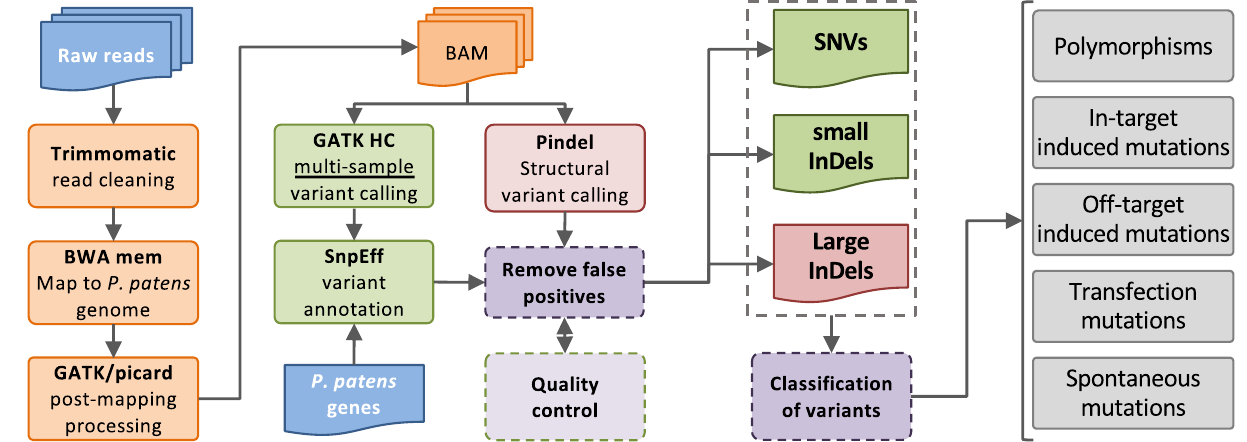
Figure 2. Workflow of whole-genome SNV and InDel analysis. SNV and small InDels (< 50 bp) detection was done using HaplotypeCaller algorithm from GATK tools. Large InDels detection was done using Pindel